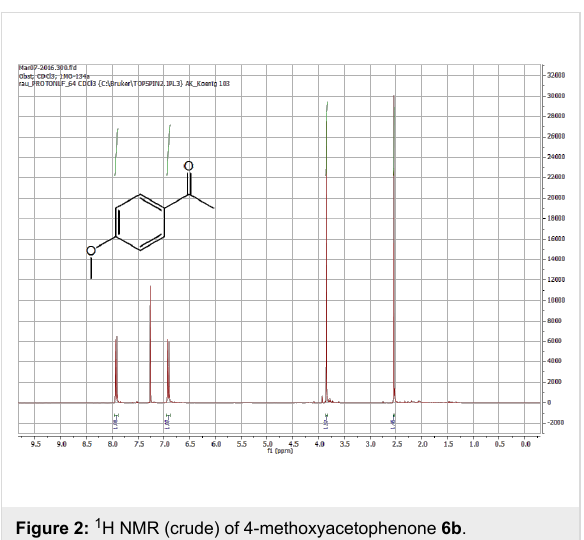
Figure 2: 1 H NMR (crude) of 4-methoxyacetophenone 6b